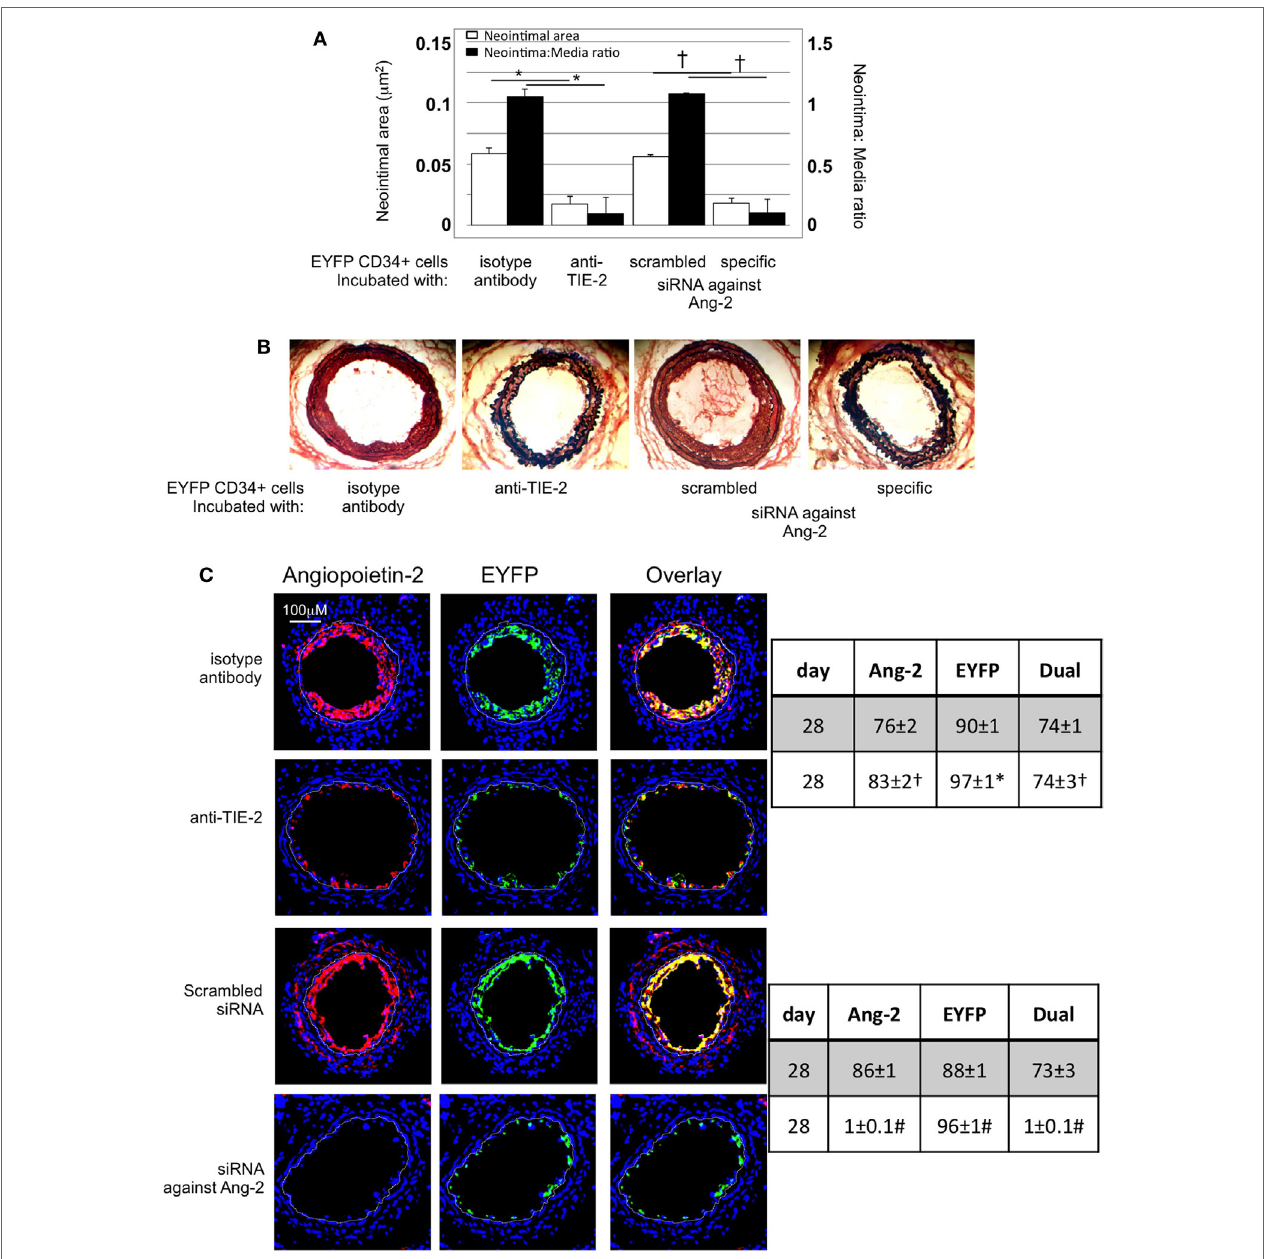
FigUre 8 | Pre-incubation of enhanced yellow fluorescent protein (EYFP) CD34 + cells with reagents to target angiopoietin-2 prior to adoptive transfer. (a) Neointimal area (left axis, white bars) and neointima:media ratio (right axis, black bars) of vessels taken from wild-type (WT) animals 28 days post-injury after adoptive transfer of 1 × 10 6 EYFP CD34 + cells that were either pre-incubated with isotype control antibody, an anti-TIE-2 antibody, control scrambled siRNA or specific siRNA targeting angiopoietin-2, and administered immediately post-injury. Data derived from examination of three random sections from six different vessels. * p < 0.001, † p < 0.001. (B) Cross sectional images of WT carotid artery 28 days post-injury stained with elastin van Gieson’s stain after adoptive transfer of cells pre-incubated with the same reagents as above. (c) Panels show immunohistology of sections through injured mouse carotid arteries harvested on day 28 post-injury. All sections stained with DAPI (4,6 diamidino-2-phenylindole) nuclear stain (blue) and anti-angiopoietin-2 (red). The green staining is light emitted by the EYFP cells themselves. Yellow indicates co-localization. The annotated white line defines the junction between neointima and media. Compared to the cells incubated with isotype control antibody, the anti-TIE-2 antibody significantly reduced the neointimal area but did not inhibit angiopoietin-2 expression. Compared to the scrambled siRNA, the specific siRNA targeting angiopoietin-2 significantly reduced the neointimal area in association with abolition of angiopooietin-2 expression by EYFP cells. Tables besides panel (c) describe summary of staining from all mice ( n = 6), showing the proportion of the neointimal area that is positive for EYFP, angiopoietin-2, or both on day 28 (% ± SEM). Data derived from three random sections from each of the arteries from each mouse (see Materials and Methods). Subtracting the proportional area occupied by dual positive cells from the total area occupied by angiopoietin-2 + cells gives the proportional area occupied by non-adoptively transferred angiopoietin-2 + cells. *cf isotype for anti-TIE-2 p < 0.001. † cf isotype for anti-TIE-2 p = NS. # cf scrambled siRNA p < 0.001. Experiments repeated at least